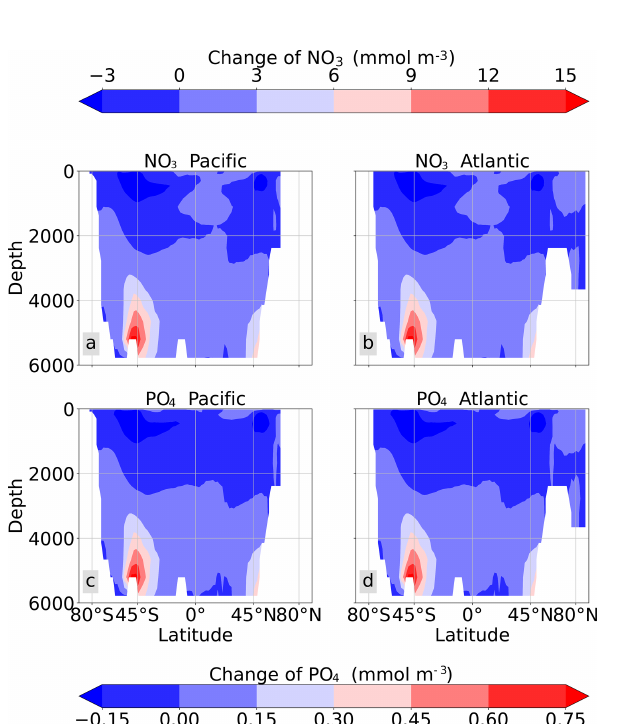
Figure B2. Nutrients horizontal-distribution changes in the Pacific & Atlantic basins (MOS_Conti) relative to RCP 4.5 at year 2100. The nutrients trapping by MOS can be observed on the upper layers at, e.g., the Southern Ocean and mid–high latitudes in the Northern Hemisphere. The nutrients are enriched at the ocean bottom by the remineralization of MOS biomass, especially in the Southern Ocean deep